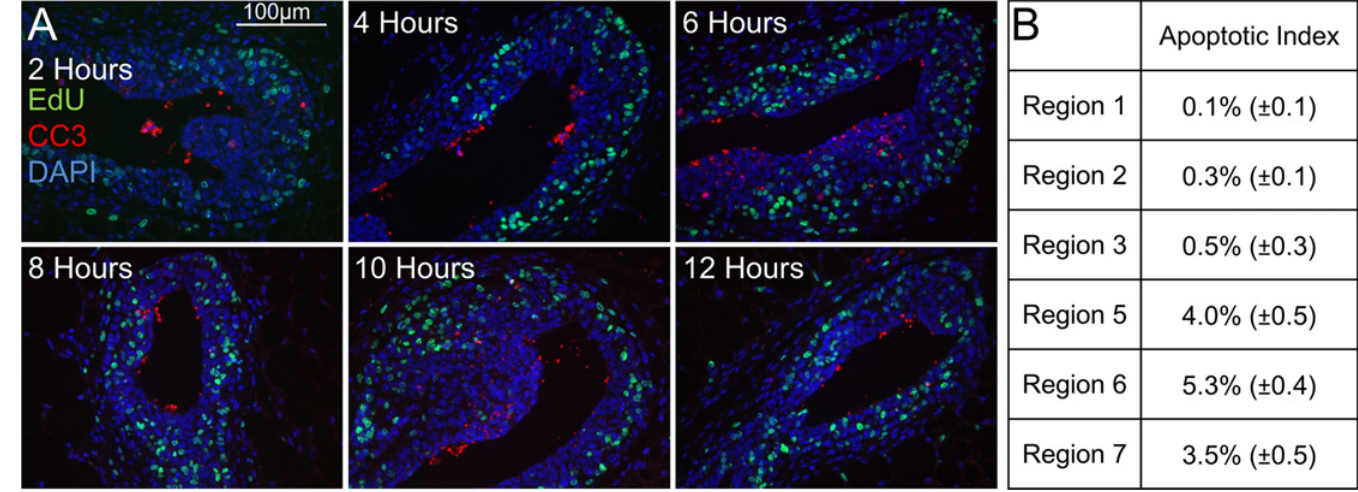
Fig 3. Analysis of apoptosis by Cleaved Caspase III (CC3) staining. Apoptotic levels were determined by cleaved caspase III staining. A) Representative images of TEBs stained for CC3 and EdU incorporation. B) Quantification of CC3 positive cells indicates the majority of apoptosis occurs in Regions 5, 6, and 7 (n = 50 TEBs). See also S4